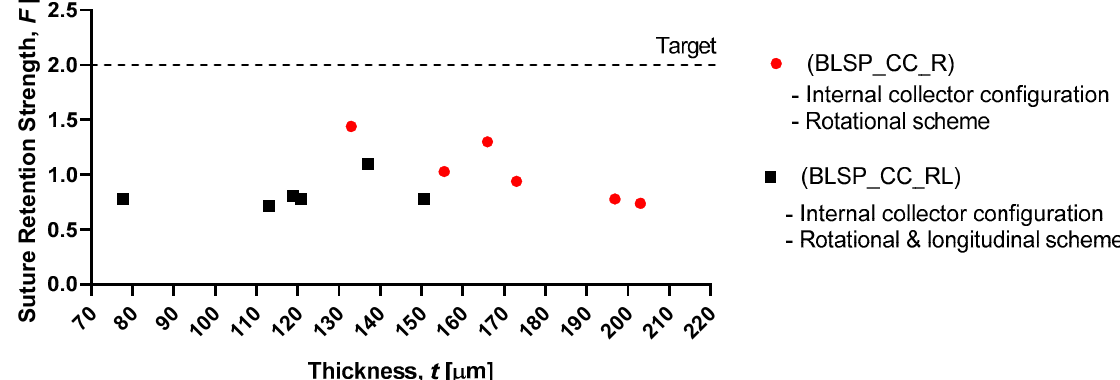
Figure 19. Suture retention strength. (A Student’s t-test was performed to determine any statistically significant differences between experiments. All tests were carried out at a 95% confidence interval and the results did not show statistically significant differences.) Figure 20. Membrane thickness vs. graft suture retention Figure 20. Membrane thickness vs. graft suture retention strength . Table 4. Summary of morphology and mechanical properties.